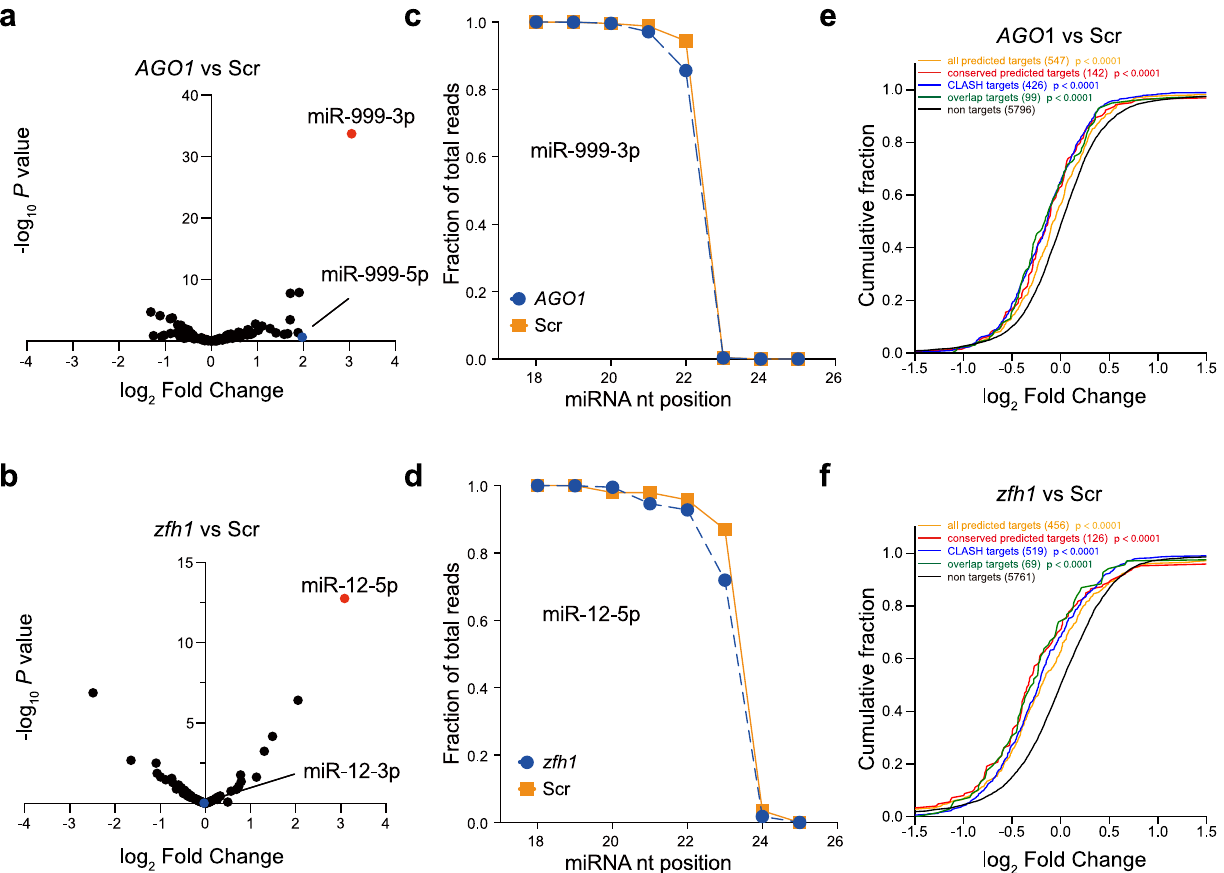
Fig. 4 | TDMD triggers in fl uence miRNA abundance, 3 ′ end extension and function. Thein fl uenceofTDMDtriggeronmiR-999( a )andmiR-12( b )abundance in AGO1 and zfh1 trigger-KO cells compared to control-KO cells. miR-999 and miR- 12areindicatedbyreddots,asthebluedotsrepresenttheirpassengerstrands.The fractionofsmallRNA-seqreadswithcoverageof18-26nucleotides(nt)formiR-999 ( c ) and miR-12 ( d ).For each miRNA, solid lines delineate the control samples, dash lines delineate the TDMD trigger-KO samples. Data are presented as mean value from two biological replicates. Repression of miR-999 ( e ) or miR-12 ( f ) targets in